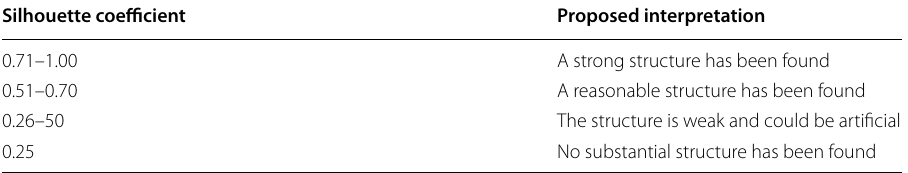
Table 16 Subjective interpretation of the Silhouette coefficient (Kaufman and Rousseeuw